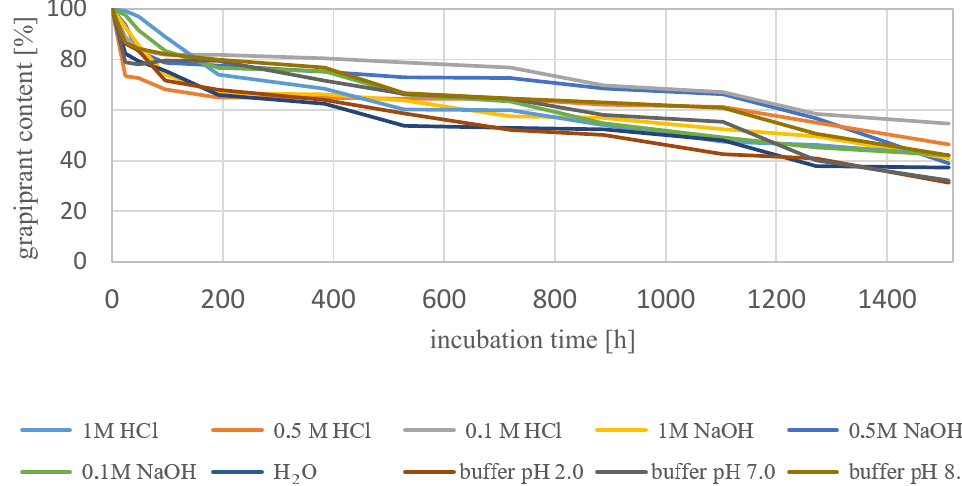
70°C. The calculated percentages of substances at each time point are summarized in Table